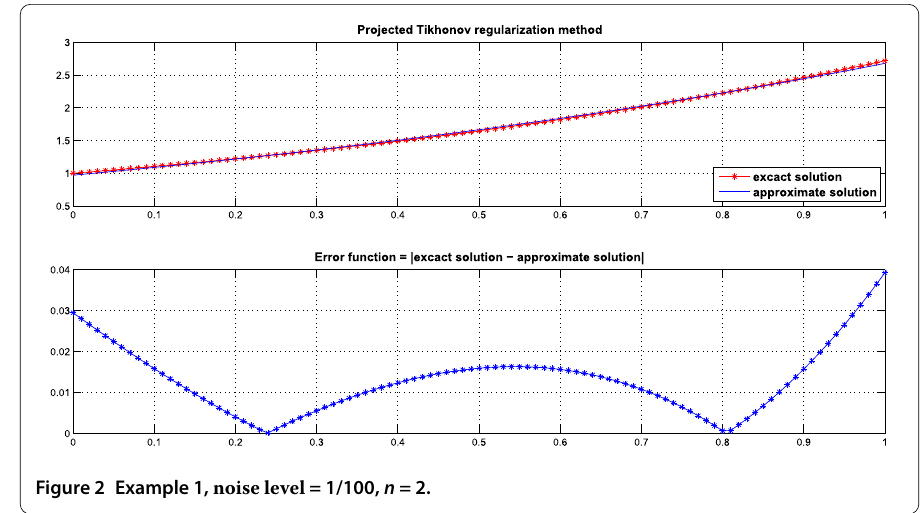
Figure 2 Example 1, noise level = 1/100, n = 2.